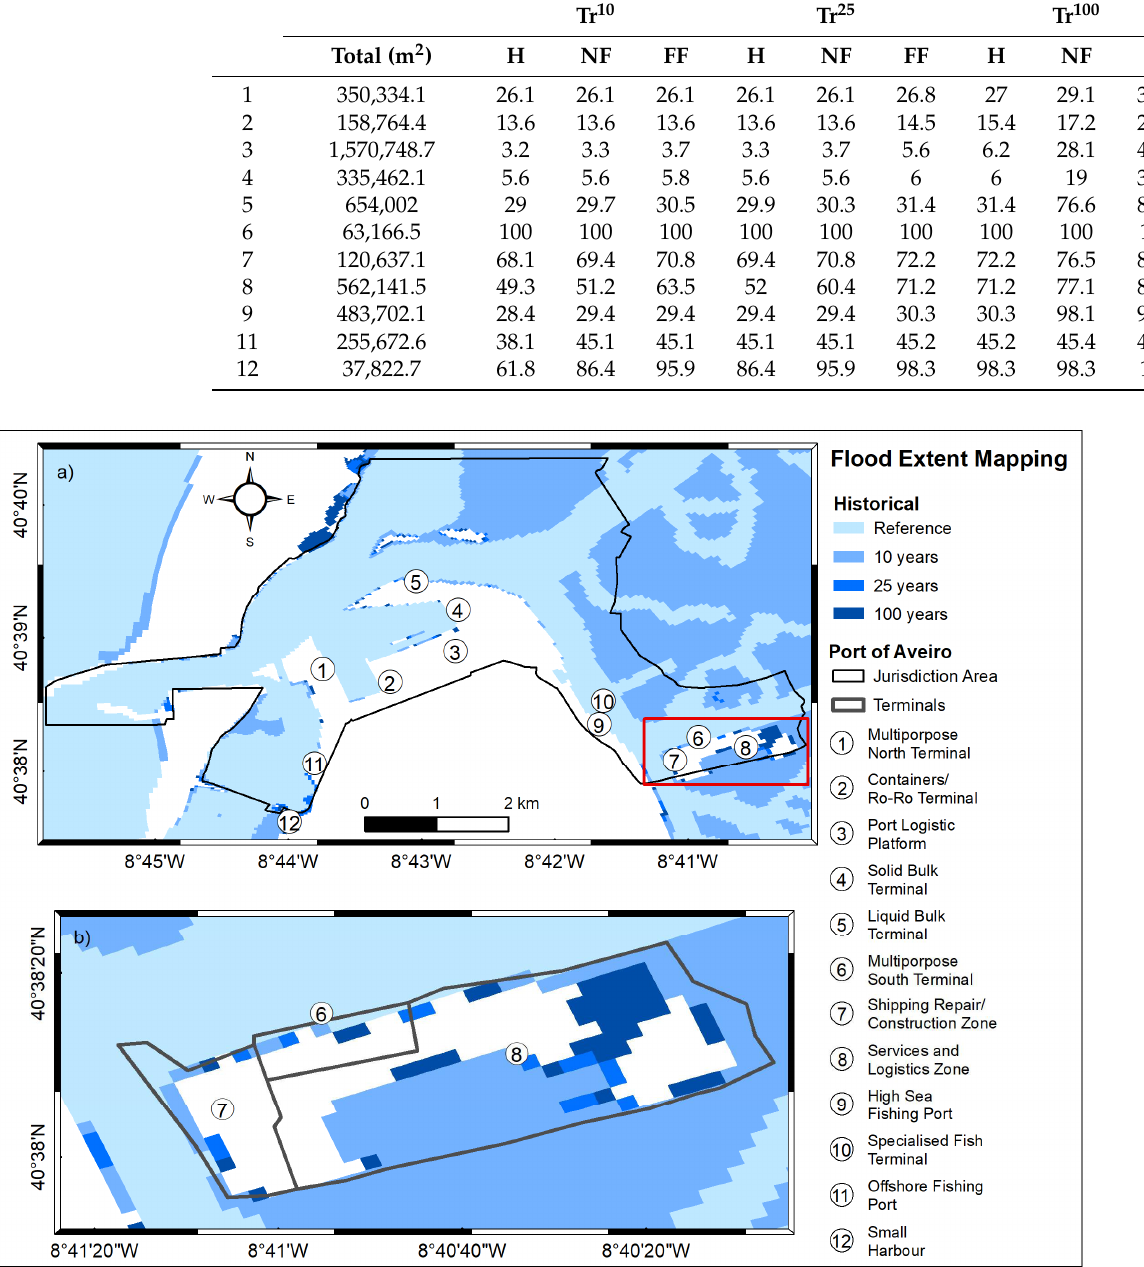
Table 10. Flooded areas of the terminals (Figure 1) at the Aveiro Port shown in percentage (%) relative to the total area of each terminal for the historical (H), near (NF), and far future (FF) periods and for the 10-, 25-, and 100-year return periods. Terminal 10 is not shown due to being designed as a single berthing dock.